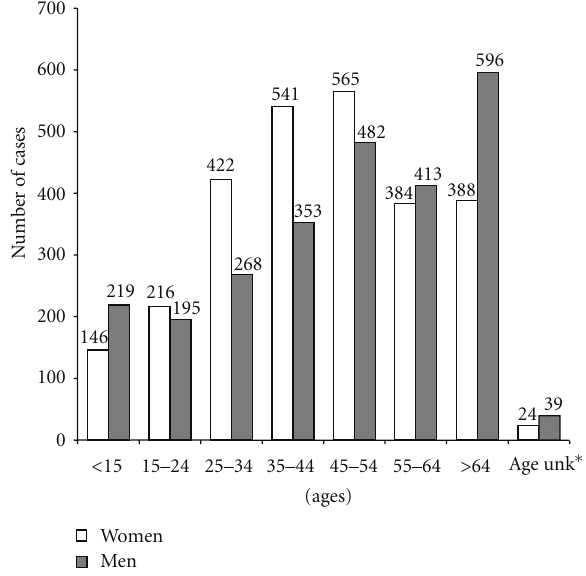
Figure 1: Distribution of cancers according to age and sex. ∗ unk: